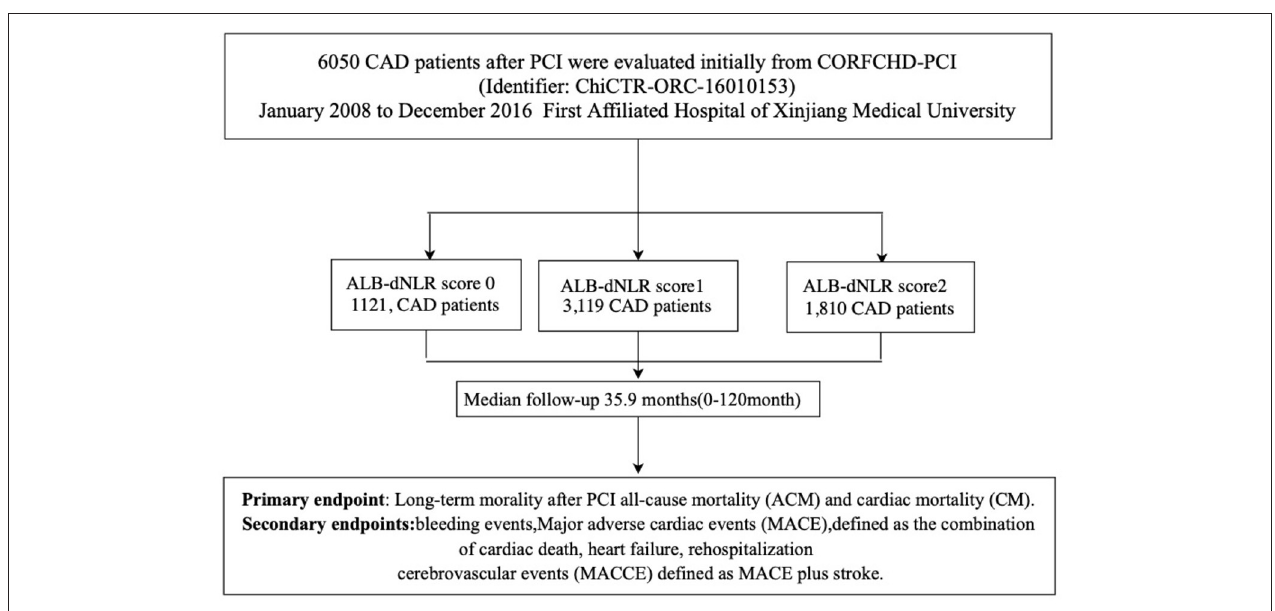
FIGURE 1 | Flow chart of participants